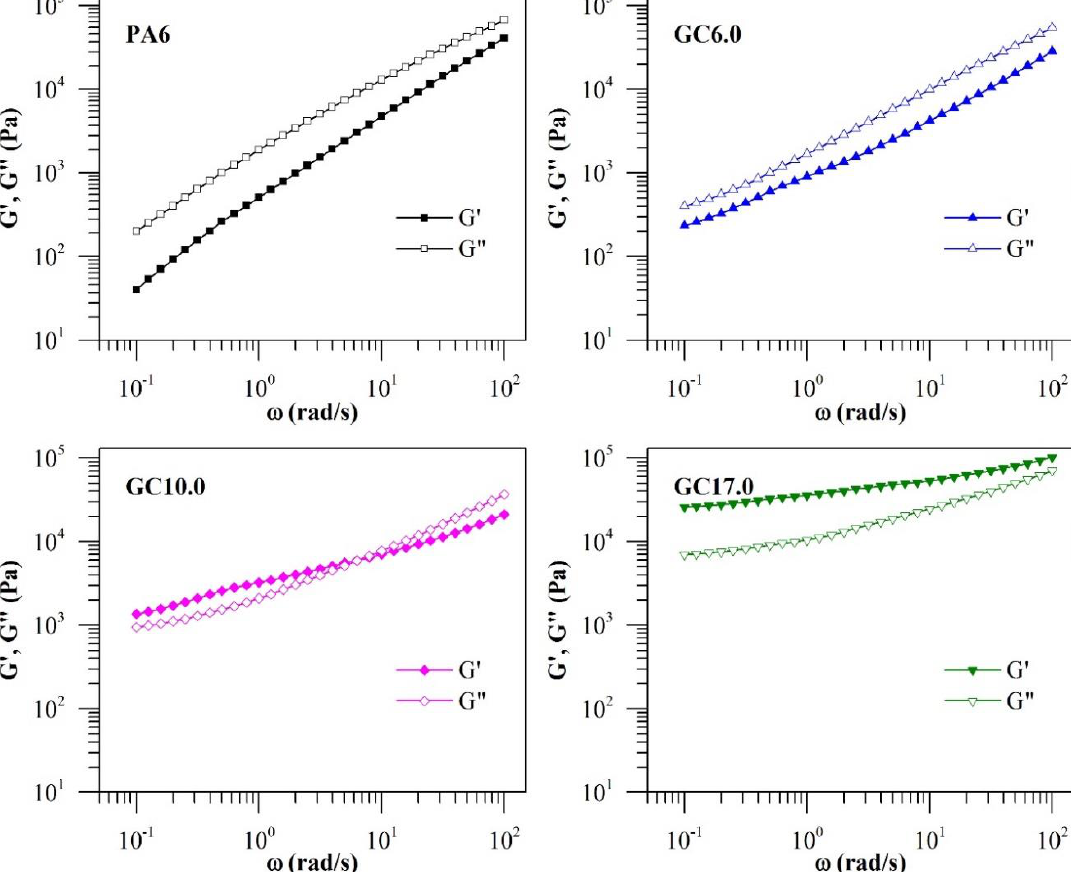
Figure 3. Comparison between G’ and G” of neat PA6 and GC.